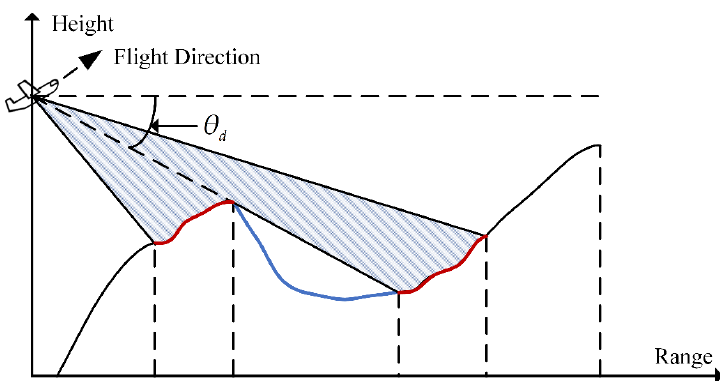
Figure 3. Illustration of the traditional angle-based occlusion judgment